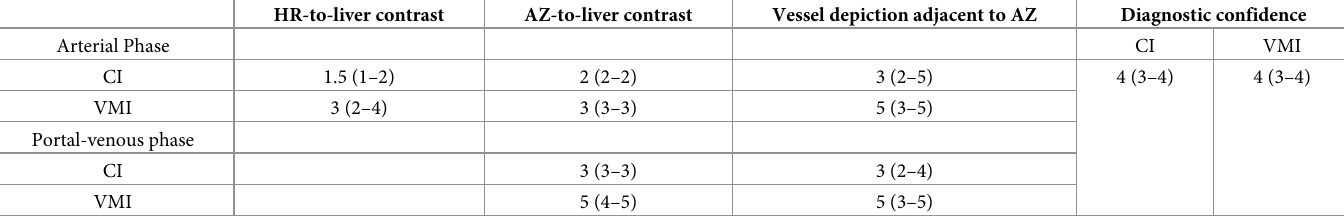
Table 5. Results of qualitative analysis. HR-to-liver contrast AZ-to-liver contrast Vessel depiction adjacent to AZ Diagnostic